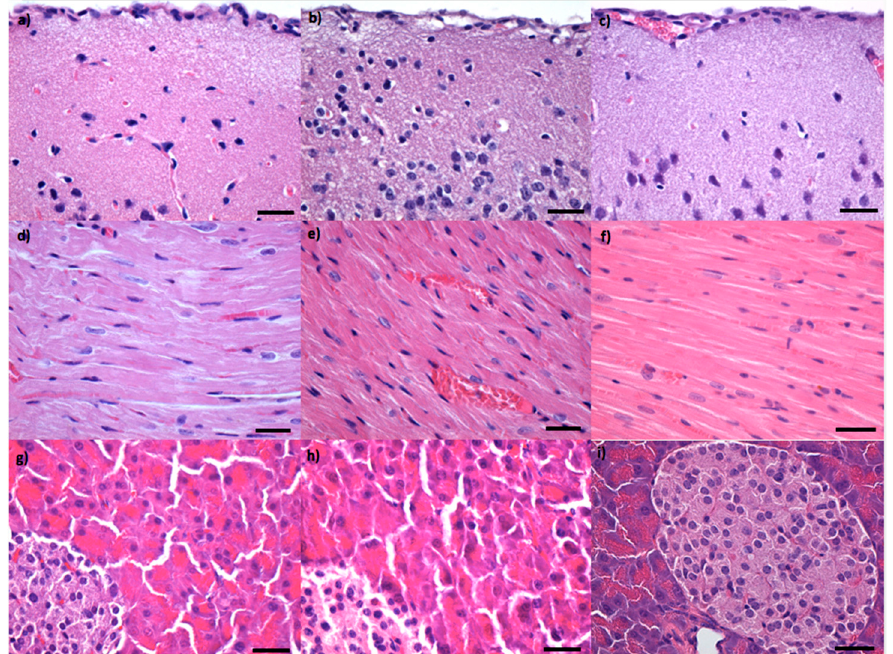
Figure 5. Cross-section through ( a – c ) brain, ( d – f ) myocardium, and ( g – i ) pancreas from mice injected with Fe 3 O 4 ( a , d , g ), Fe 3 O 4 @PEG 20 K ( b , e , h ) and Fe 3 O 4 @PEG 35 K NPs ( c , f , i ), respectively, and harvested at 10 days after intravenous administration; normal morphology; Hematoxylin–Eosin staining; 400× magnification, scale bar 50 μ m.